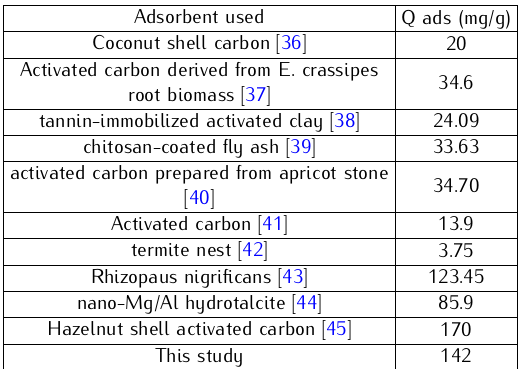
Table 4. Adsorption capacity for the adsorption of Cr VI on various adsorbents collected from literature. Adsorbent used